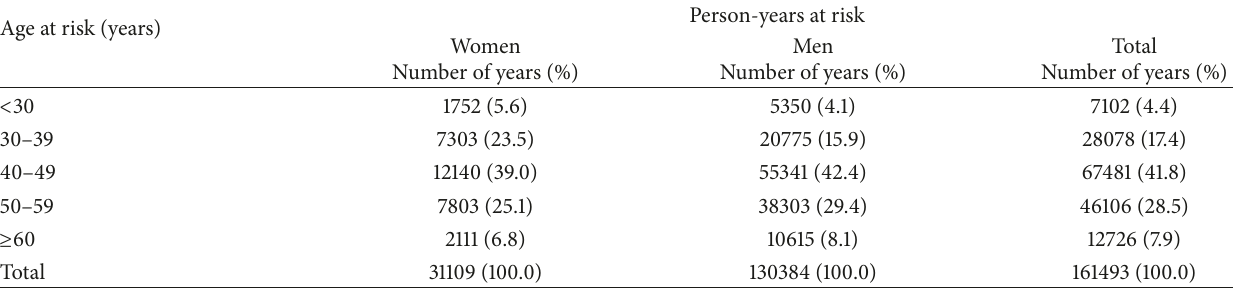
Table 1: Person-years at risk by age group.